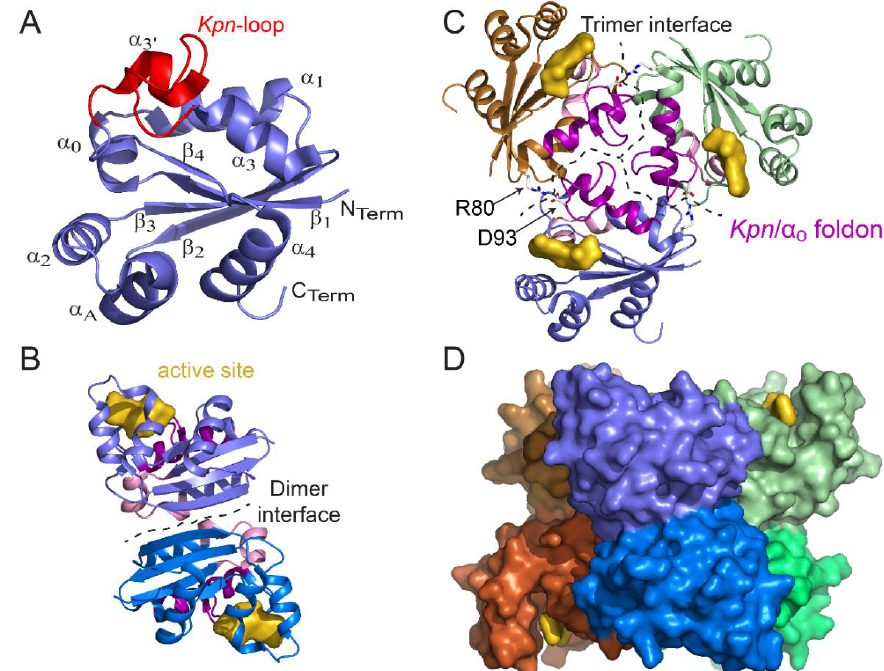
Figure 2. Structure of monomer, dimer, trimer, and hexamer of NDPK from M. tuberculosis (Figure adapted with permission from [36]). ( A ) View of the monomer with labeled secondary structural elements. ( B ) Side view of a dimer showing the dimer interface (residues 17, 19–21, 23, 24, 27, 33–38, and 72) and the active site pocket (K10, Y50, R104, N114, H117, S119, and E128). ( C ) Top view of a trimer. Atthetrimerinterface(residues16, 25, 28–31, 79, 80, 83, 84, 87, 88, 93–96, 98–102, and105–110), the Kpn / α 0 foldon (the Kpn -loop and the α 0 helix are colored magenta and pink, respectively) and the R80–D93 salt bridge (sticks) are involved in hexamer assembly. The trimer stacks in a “head-to-head” manner and not in a “head-to-tail” manner such that the Kpn / α 0 foldon is exposed on either side of the hexamer. ( D ) Side view of the surface of the six-color hexamer Mt-NDPK. The active site is colored yellow. In panels B and C, the chains are colored as in panel D. All structure figures were drawn using PyMOL molecular graphic system